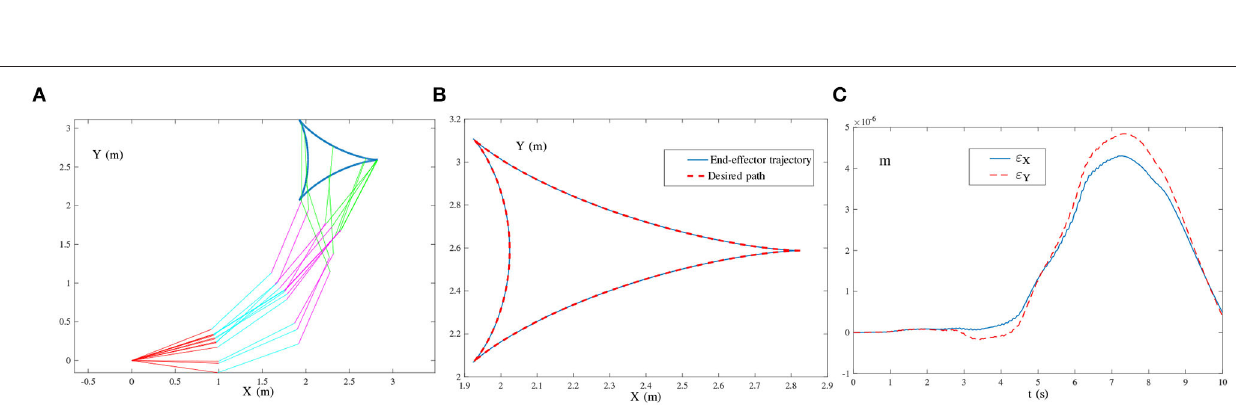
FIGURE 10 | End-effector of the four-link planar robot manipulator tracking the tricuspid path synthesized by the ZNN-combined kinematic control method in (28) using τ = 10 and λ = 1, where multiple-harmonic noise is considered. (A) Simulated motion trajectories. (B) Path and trajectory. (C) End-effector positioning